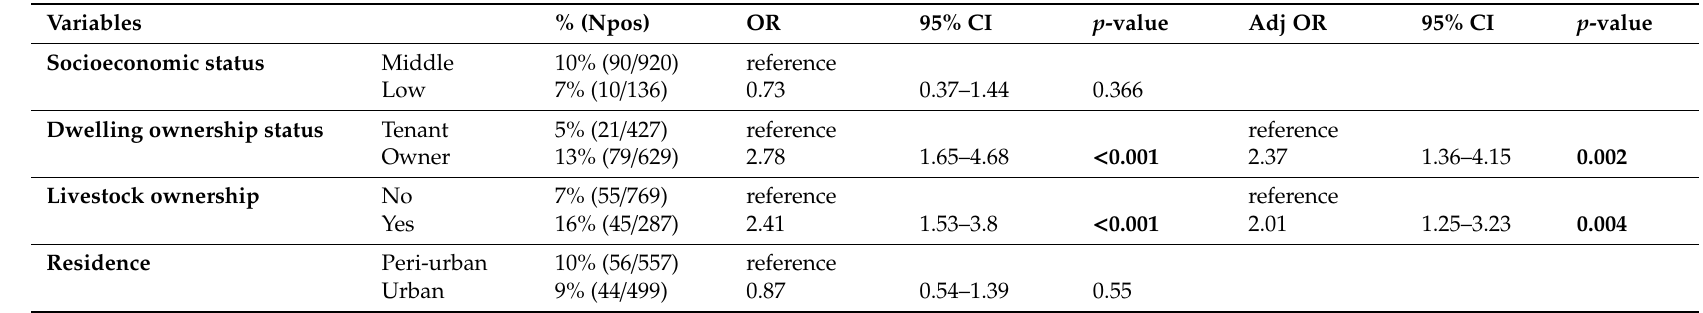
Table 2. Uni- and multivariable generalized estimating equation models for binomial outcome variables to determine household characteristics associated with dog ownership in Matadi, Democratic Republic of the Congo (DRC) in May 2017. OR: odds ratios; CI: confidence